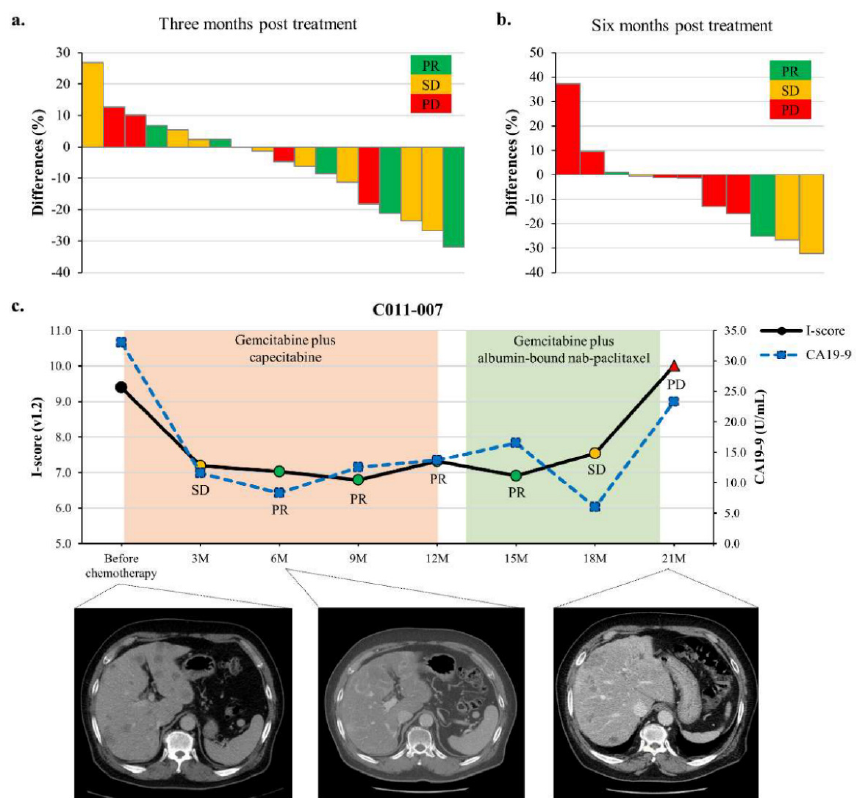
Figure 3. Monitoring of I-score according to responses in patients receiving chemotherapy. ( a,b ) The responses according to changes in I-score in 18 metastatic patients. At six months post-treatment, two patients with 37.2% or 9.6% increased I-score showed progressive disease (PD). In contrast, two (40%) of five patients with a 13.1% or 15.9% decrease in I-score showed progressive disease. ( c ) Case presentation with computerized tomography (CT) images.